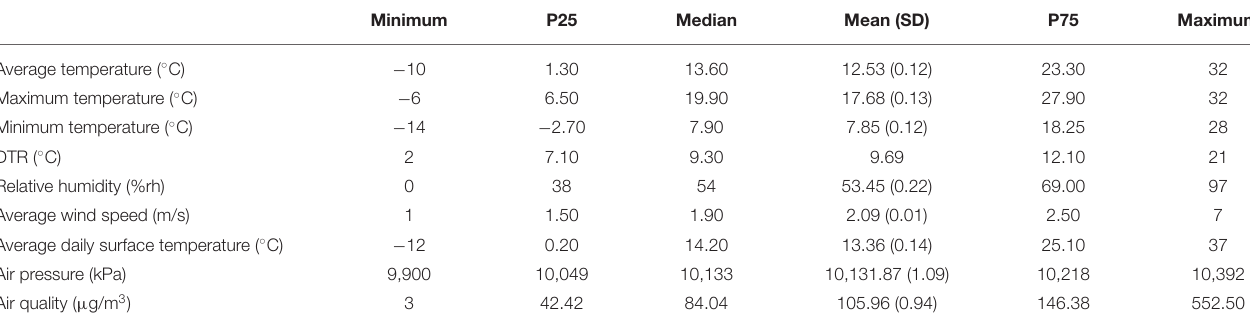
TABLE 1 | The information of air quality and meteorological conditions in Beijing, 2011–2014. Minimum